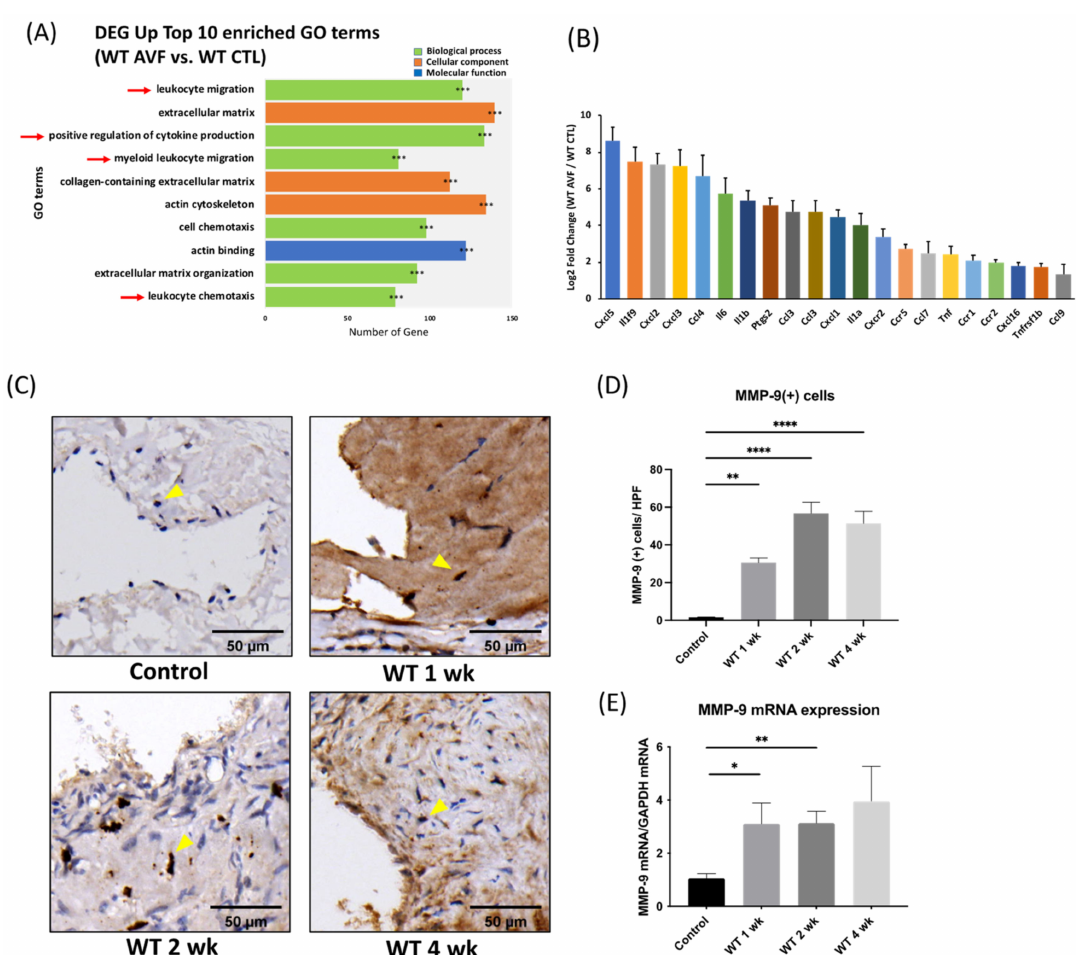
Figure 2. Vascular inflammation and increased matrix metalloproteinase 9 (MMP-9) expression in AVF venous segment. ( A ) RNA-seq data analysis revealed four out of the top 10 enriched gene ontology terms were related to inflammation. In wild-type (WT) AVF compared to contralateral veins sampled 1-week post AV fistula creation. *** p adjust < 0.001 ( B ) The expression of multiple proinflammatory genes, including chemokines and cytokines, was also elevated ( n = 3 in each group). ( C , D ) Using immunohistochemical staining, MMP-9(+) cells in neointima lesions increased significantly after AV fistula surgery, scale bar = 50 µ m. ( n = 6–7 in each time point). ( E ) MMP-9 mRNA expression was upregulated at the early perioperative phase as well. ( n = 6–7 in each time point). * p < 0.05, ** p < 0.01, **** p < 0.0001. Data presented as mean ± SEM and analyzed by one-way analysis of variance (ANOVA) followed by Bonferroni post hoc analysis. CTL, control; DEG, differentially expressed genes; GO, gene